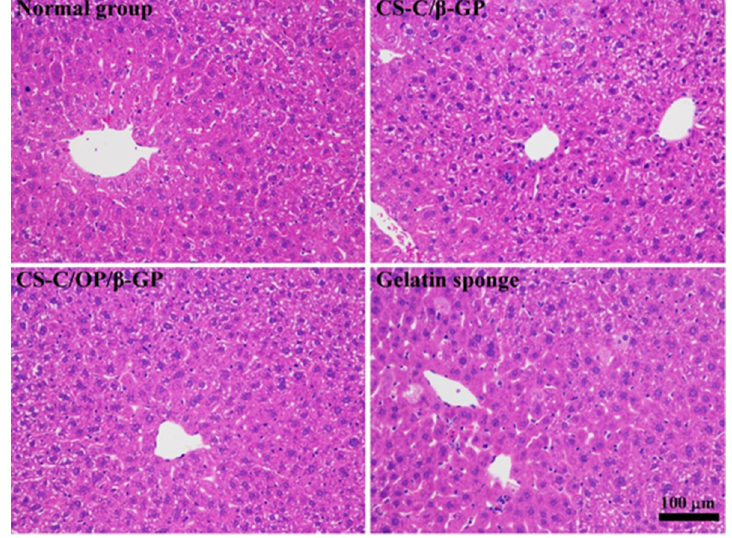
Figure 5. Hematoxylin and eosin (H&E) stained micrographs of liver tissues.